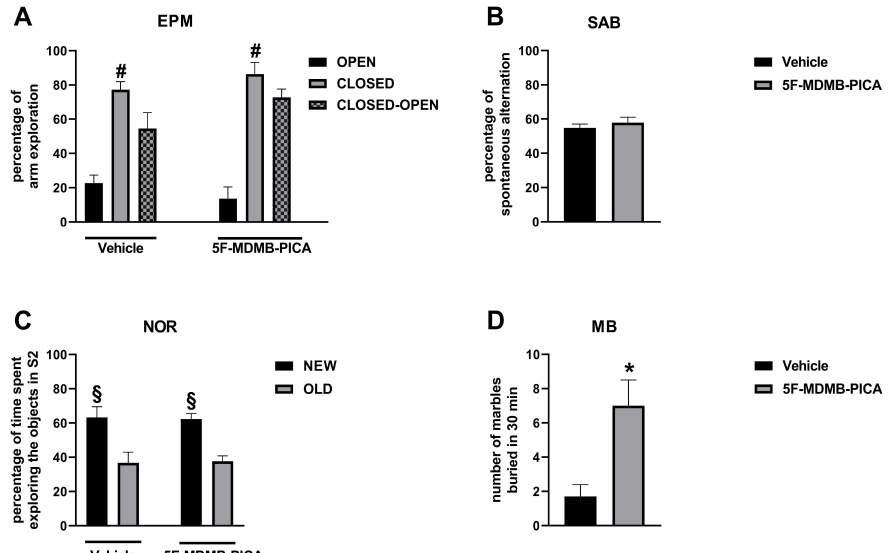
Figure 4. Results of behavioral tests performed in adult mice treated with vehicle or 5F-MDMB PICA (0.01 mg / kg, i.p.) as adolescents. Result are expressed as mean ± SEM of the percentages of ( A ) arm exploration in the EPM. ( B ) SAB in the Y maze. ( C ) Object exploration in the NOR test as well as of the numbers of marbles buried in the EPM, elevated plus maze. ( D ) NOR, novel object recognition. MB, marble burying test. # p < 0.05 vs. open arms within each experimental group. § p < 0.05 vs. old objects within each experimental group. * p < 0.05 vs. mice treated with vehicle as adolescents. Vehicle-treated mice N = 8–10; 5F-MDMB PICA-treated mice N =